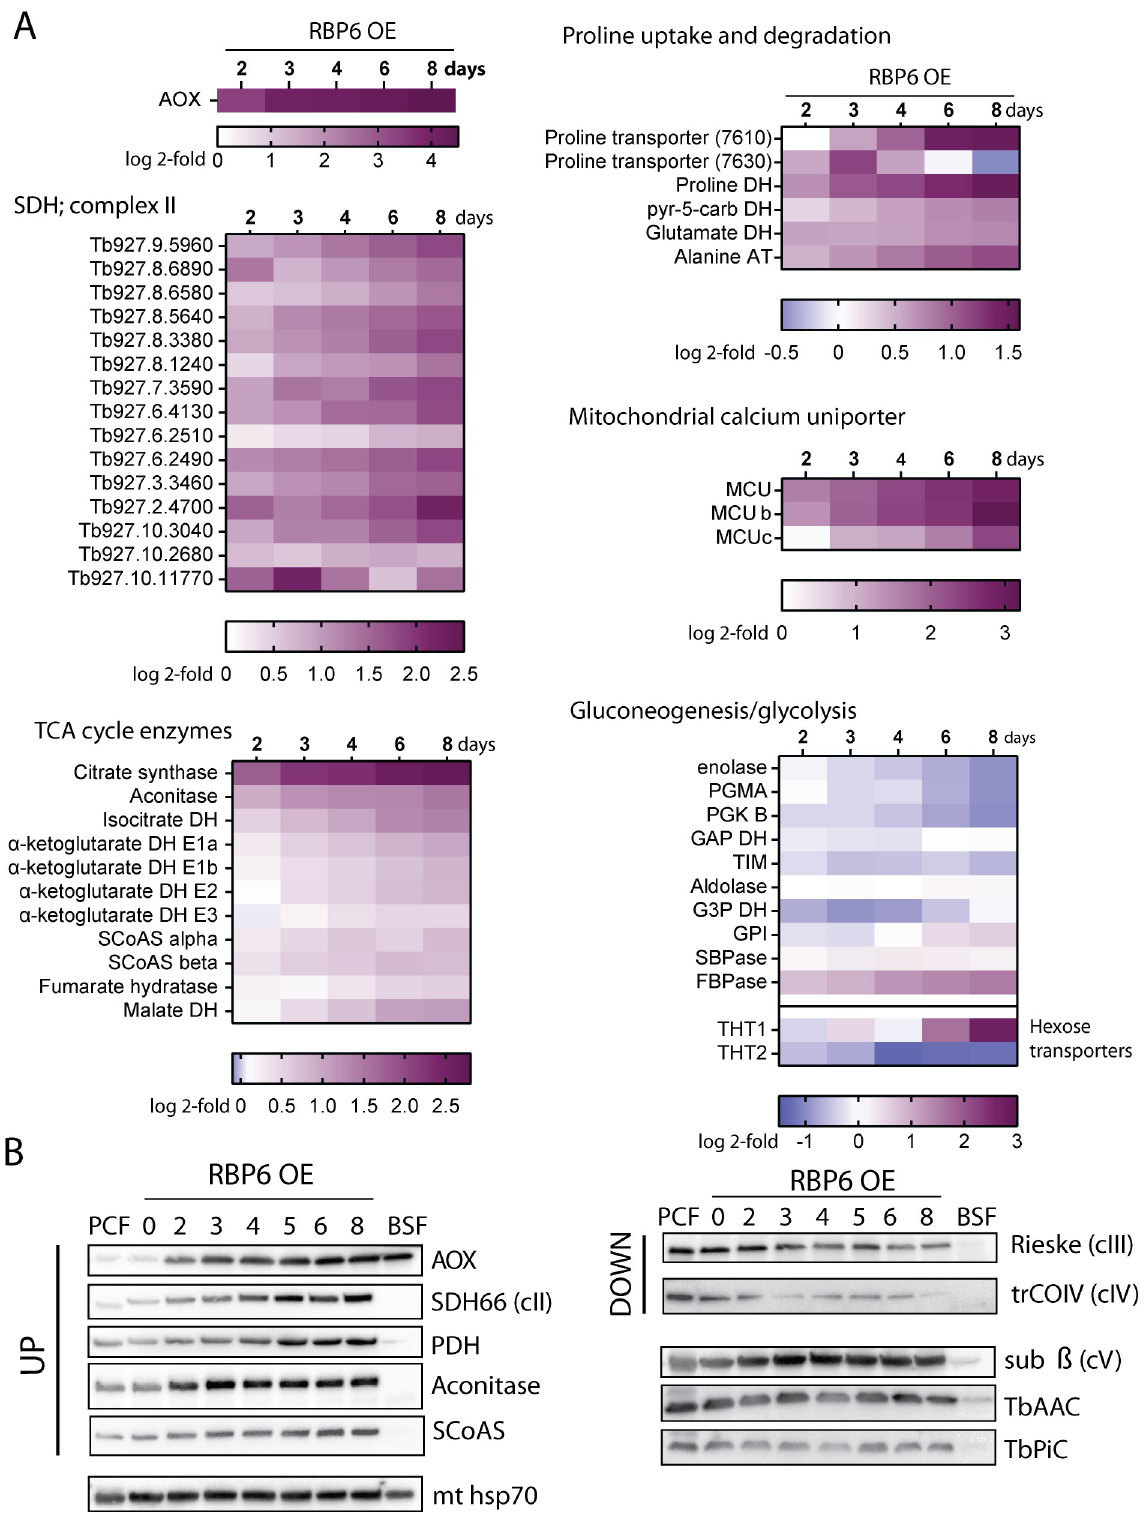
Fig 3. Major changes in protein abundance during RBP6 overexpression. (A) Heatmaps showing log2 fold change of average LFQ intensities of selected proteins identified in induced samples compared to uninduced. The color key differs for each map and is always located below the heatmap. (B) Western blot analyses of whole-cell lysates from RBP6 OE cells undergoing differentiation using a panel of various